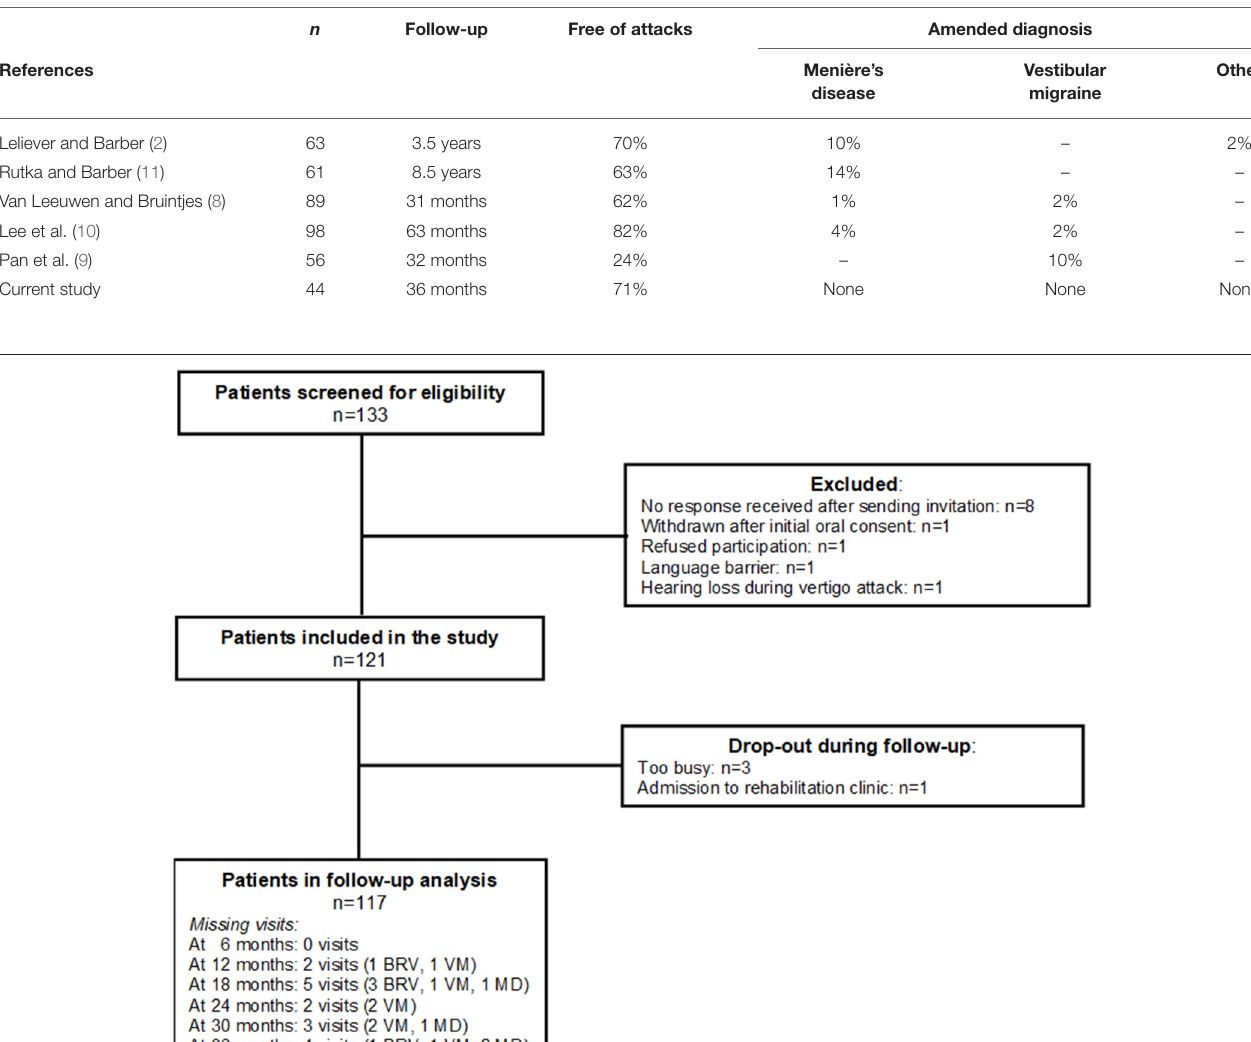
TABLE 1 | Previous studies and the current study on vertigo attacks in patients with benign recurrent vertigo. n